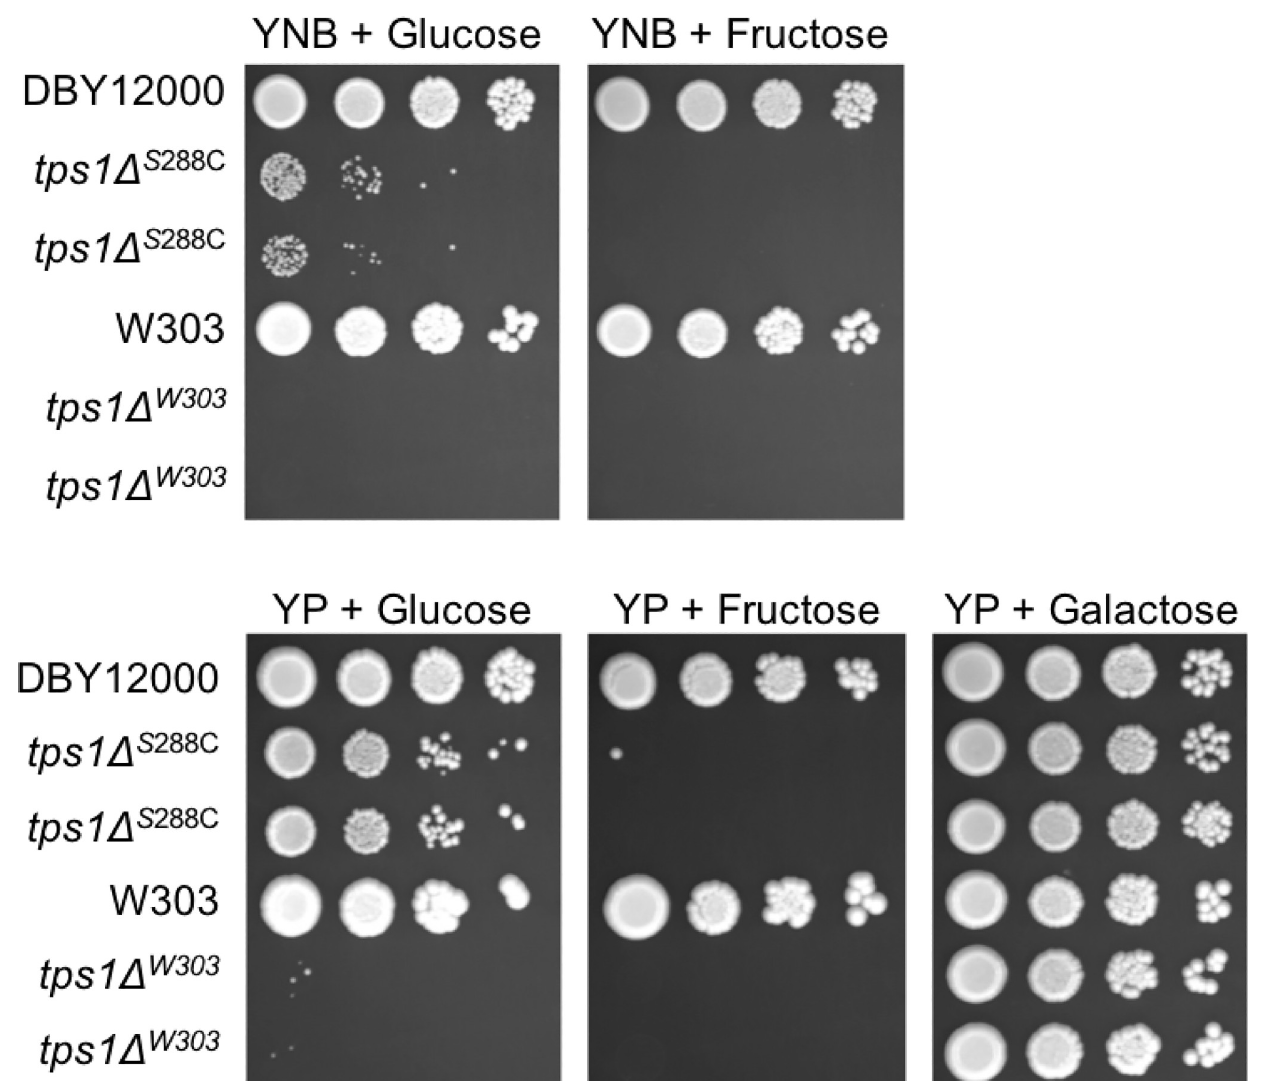
Fig 1. tps1 Δ persister-like state occurs in S288C-derived strains, doesn’t occur in fructose, and is enhanced by rich media. The indicated strains were grown overnight in YNB + 2% galactose liquid before 10-fold serial dilutions were prepared and spotted onto the indicated media. Listed carbon sources were present at 2%. The initial dilution had an OD 600 of 1.0. Plates were incubated at 30˚C for 3 days. Two biological replicates of each tps1 Δ mutant are shown (immediately below their isogenic wild type strain). Strains used in this figure: DBY12000, DBY12383, DBY15117,